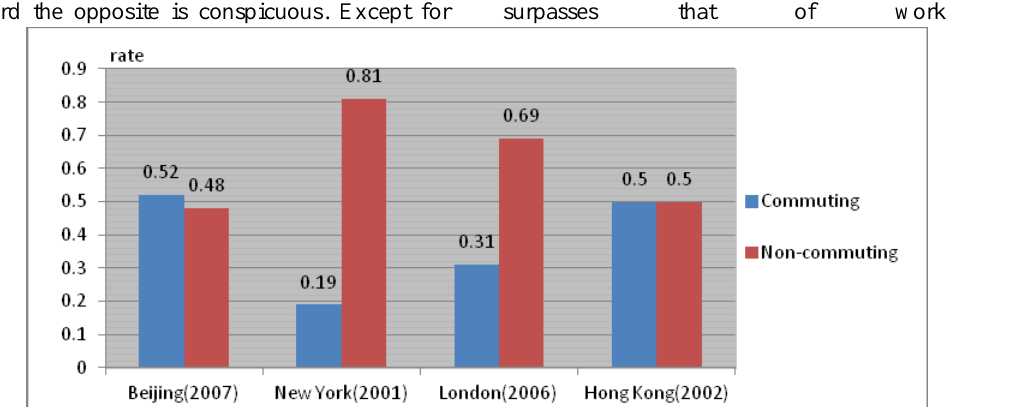
Fig. 6. Rate of commuting and non-commuting travels in Beijing, New York, London and Hong Kong Source: Annual Report of Beijing Transport Development (2008). National Household Travel Survey New York Add-On (2001); London Travel Report (2007). Hong Kong Travel Characteristics Survey